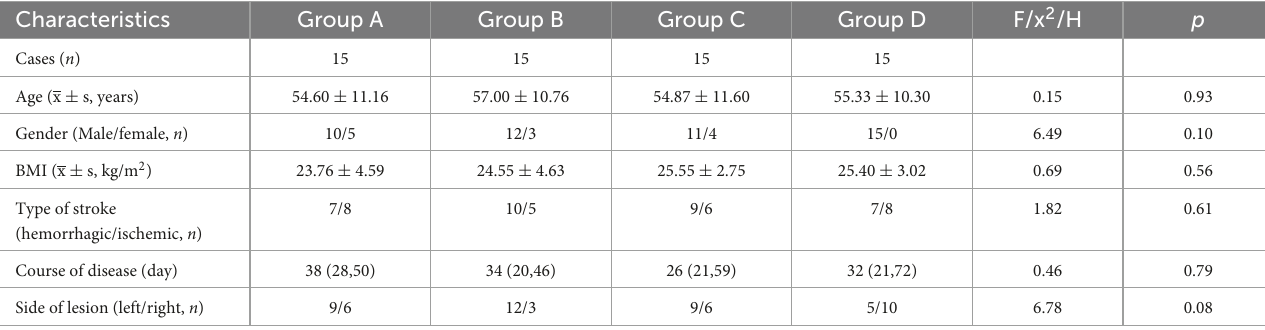
TABLE 1 Comparison of basic data of patients.